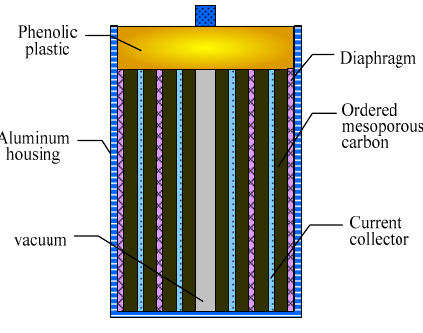
Figure 2. SC structure diagram.